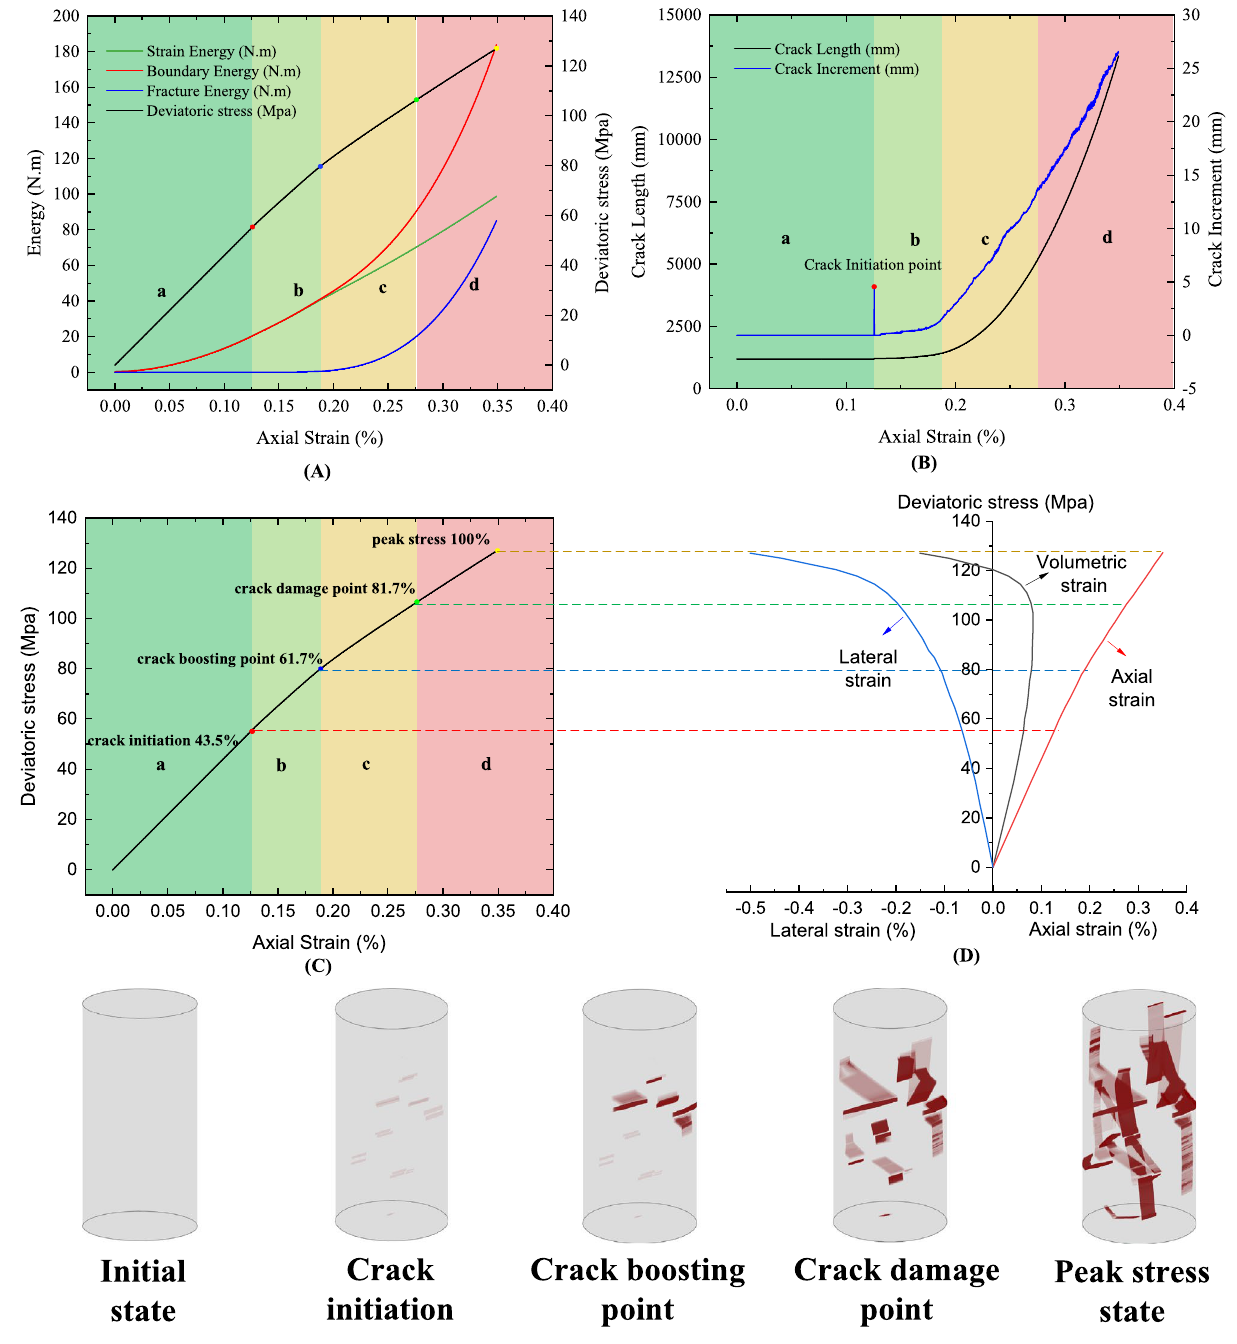
Figure 10. Simulated results with the proposed simulation method with 5 Mpa confining stress. ( A ). The deviatoric stress–strain curve and energy curves for which the boundary energy is the sum of the fracture energy and the strain energy; ( B ). The crack length and crack increment over axial strain; ( C ). The deviatoric stress–strain curve; ( D ). The deviatoric stress curves over axial, lateral and volumetric